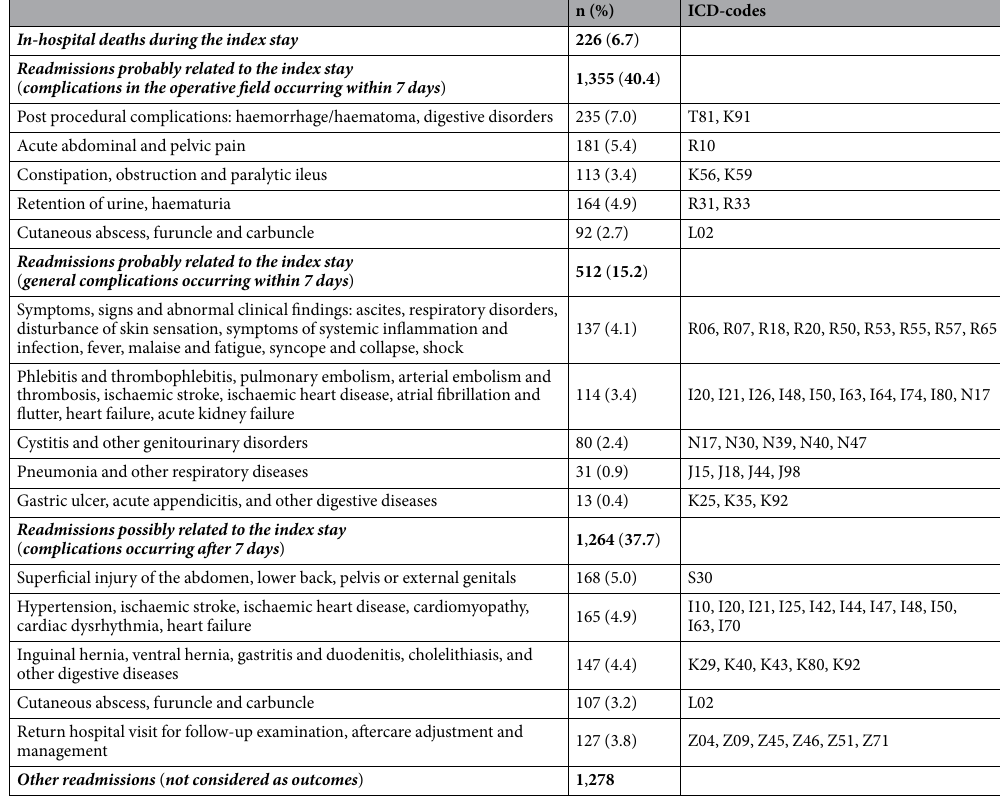
Table 1. Description of the primary composite outcome of death or 30-day readmission related to the index stay (with top five most frequent